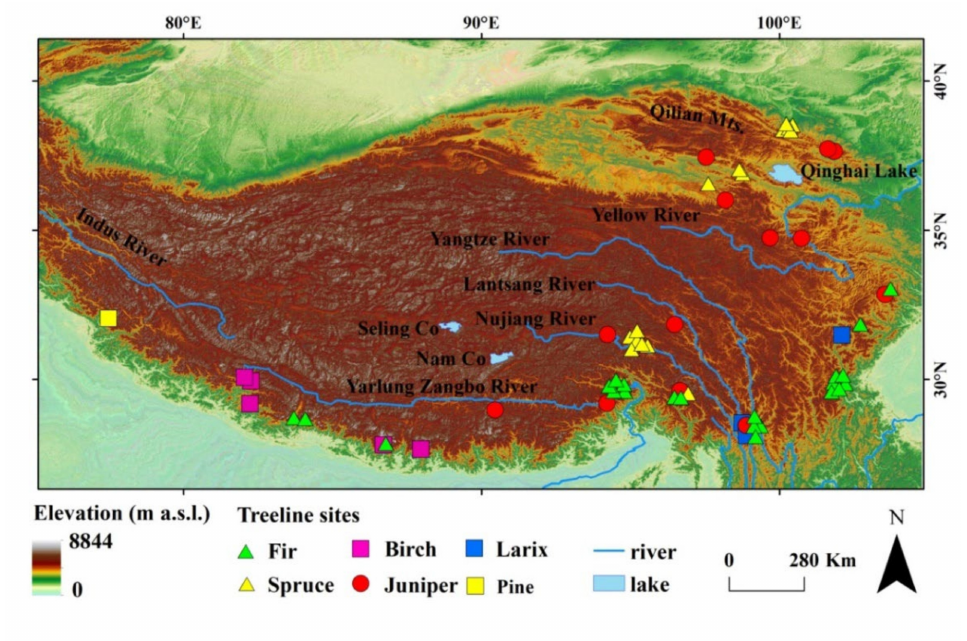
Figure 1. Locations of alpine treeline sites and tree genera (see the tree species in Table S1) forming the treelines across the